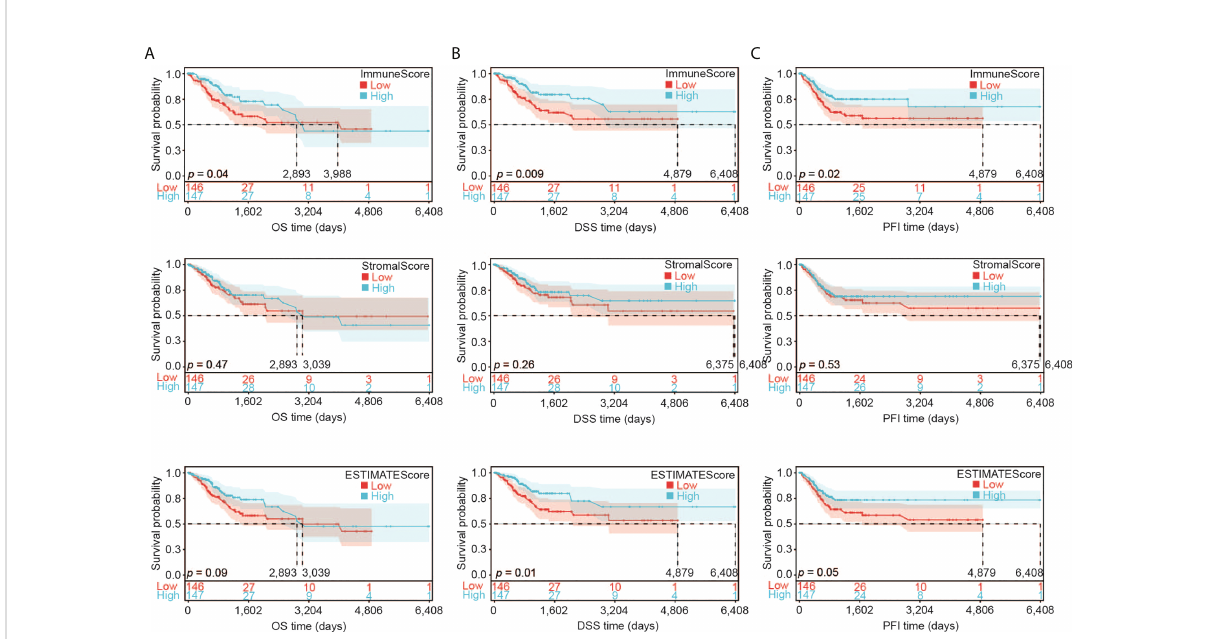
FIGURE 2 Association of ImmuneScore, StromalScore and ESTIMATEScore with CESC patients ’ prognosis. (A) Overall survival (OS) analysis of ImmuneScore, StromalScore and ESTIMATEScore for CESC patients. (B) Disease special survival (DSS) analysis of ImmuneScore, StromalScore and ESTIMATEScore for CESC patients. (C) Progression free survival (PFI) analysis of ImmuneScore, StromalScore and ESTIMATEScore for CESC